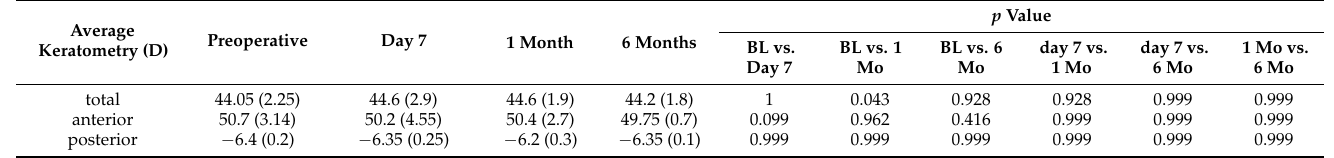
Table 2. Analysis of average keratometry in eyes with pterygium removal by autologous conjunctival autograft with human fibrin tissue